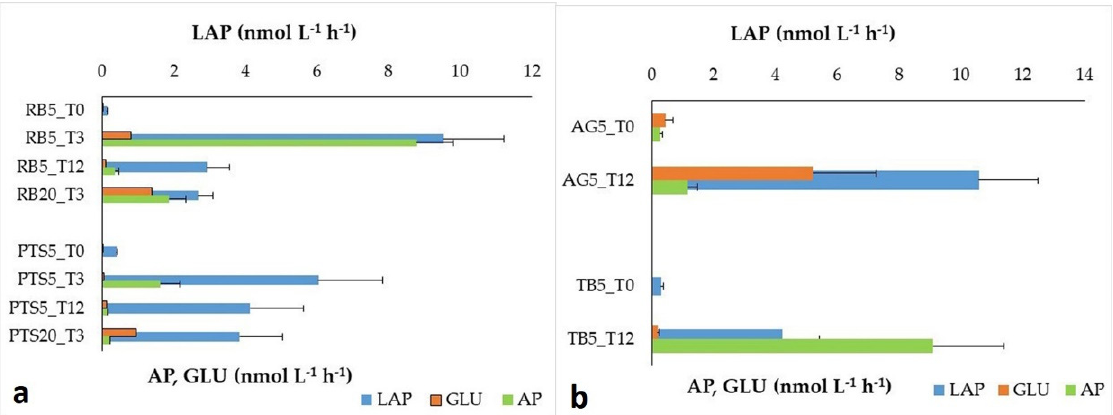
Figure 9. Mean values + standard deviations of the enzymatic activity rates (Leucine aminopeptidase, LAP; beta-glucosidase, GLU; alkaline phosphatase, AP) measured in seawater samples collected at 5 m and 20 m at the start of the experiment (Time 0, November 2017), in January 2018 (Time 3, short-term experiment) and at the end (Time 12, November 2018) of the long-term experiment. ( a ), Road Bay area; ( b ), Tethys Bay area. RB, Road Bay (impact station, on the left); PTS, Punta Stocchino (control station, on the right); AG, Amorphous Glacier (impact station, on the left). TB, Tethys Bay (control station, on the right); PVC: Polyvinyl chloride; PE: Polyethylene. In the Tethys Bay area, the enzyme patterns showed higher metabolic patterns at station AG than station TB (range LAP: 0.039–10.58 nmol L − 1 h − 1 versus 0.299–4.22 nmol L − 1 h − 1 ; GLU: 0.186–1.49 nmol L − 1 h − 1 versus 0.002–0.054 nmol L − 1 h − 1 ), except for AP (0.078–0.33 versus